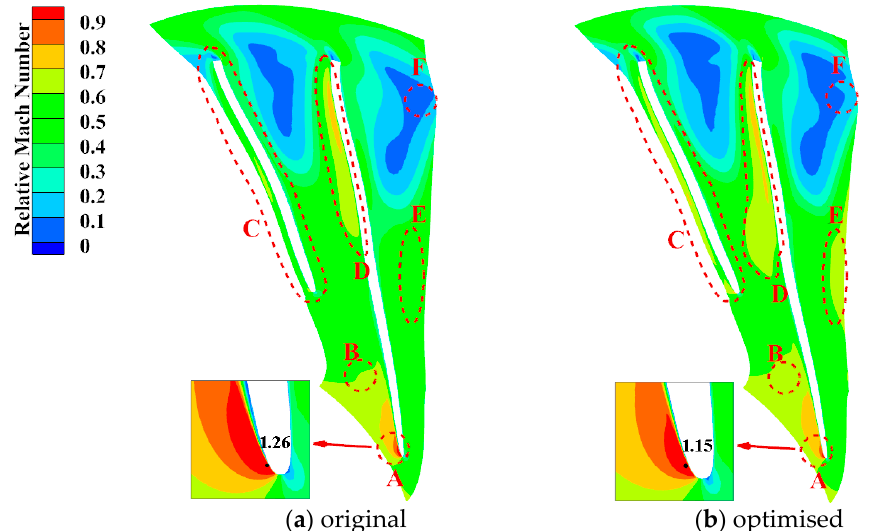
Figure 17. Comparison of the entropy contour of B2B surface at 80% height before and after optimisation (rated operating condition).